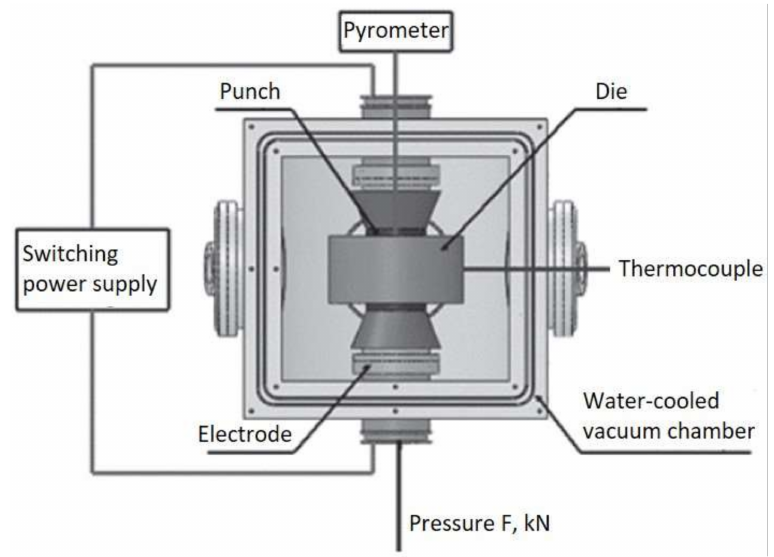
Figure 1. U-FAST